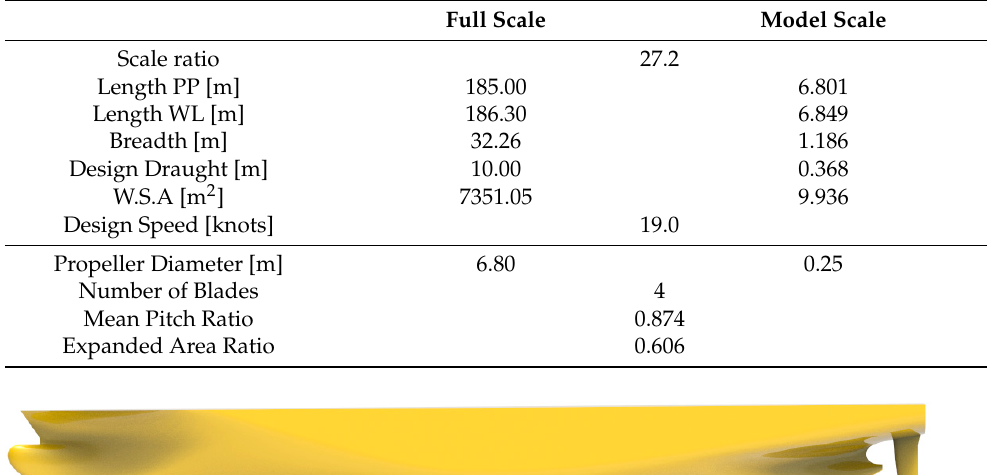
Table 1. Principal parameters of the target ship and its propeller (DS2500TEU LNG fuel feeder Container ship).